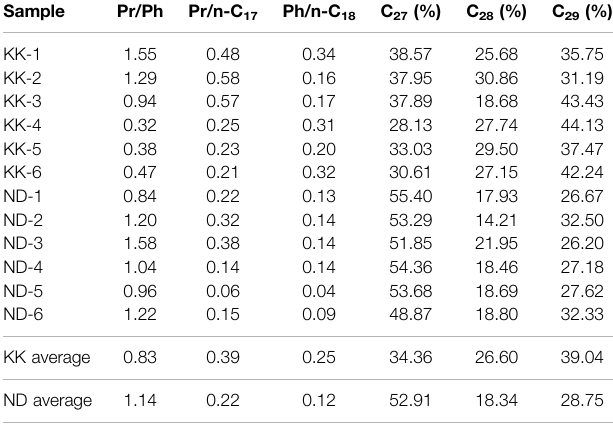
TABLE 1 | The molecular geochemical results and biomarker ratios of the Khao Khwang (KK) and Nam Duk (ND) samples. C 27 , C 28 and C 29 are regular sterane compositions converted to a percentage.